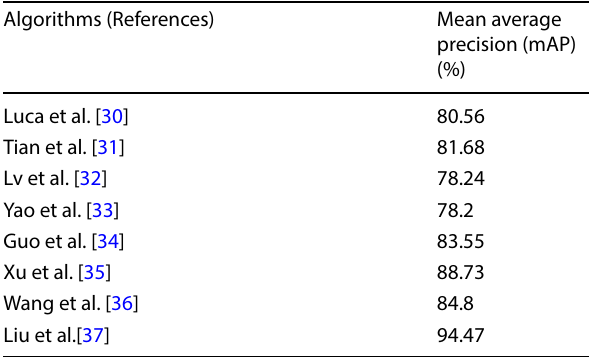
Table 1 Power equipment identification report based on multiple algorithms and its performance comparison Algorithms